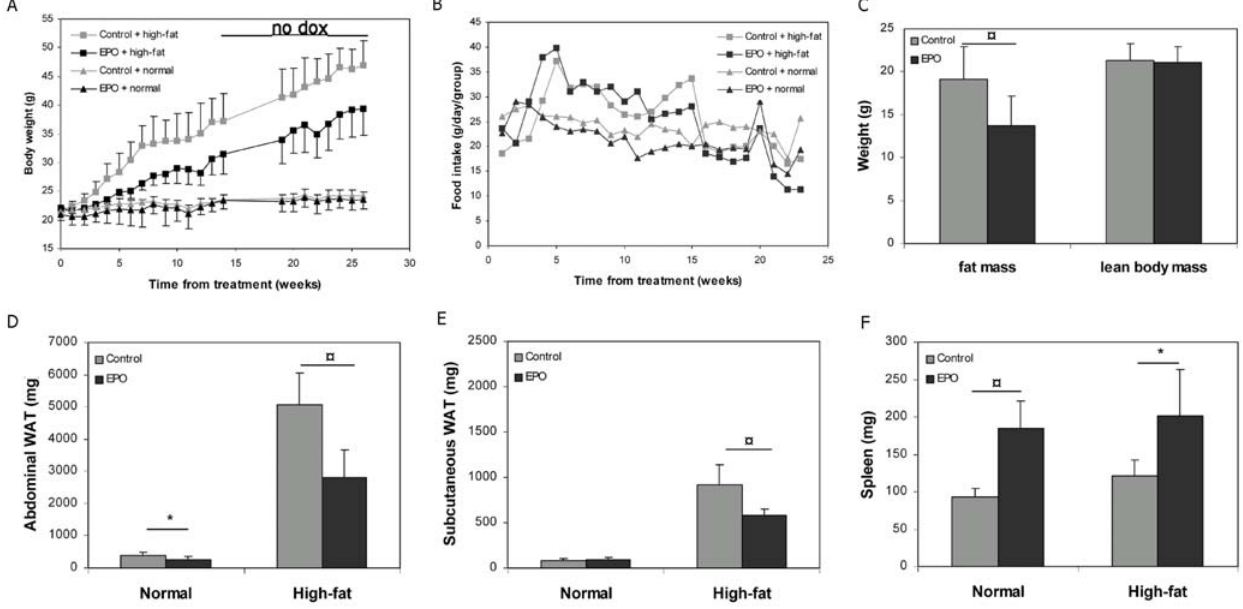
Figure 1. EPO expression diminishes diet-induced fat accumulation. One m g of EPO plasmid and each of the regulatory plasmids, pTet-On and pTetS, were electrotransferred into the right tibialis cranialis muscle of C57Black/C mice. Each group consisted of 8 mice and the mice were placed on either regular chow or a high-fat diet. Means 6 SEM are depicted. A) Body weight of the EPO transfected mice. For the first 14 weeks transgenic EPO expression was induced by administration of doxycycline in the drinking water, whereafter the doxycycline was withdrawn for the rest of the experiment. B) Food intake for the animals in A).C) Fat mass and lean body mass in thehigh-fat fed mice measured by DXA scanning 12 weeks after DNA electrotransfer. D–F) Weight of abdominal fat, subcutaneous fat and spleen 12 weeks after DNA electrotransfer. Statistical significance was tested by Student’s t-test with Bonferroni corrections for multiple testing. * indicates significance at p , 0.05, while ¤ indicates significance at p , 0.01.